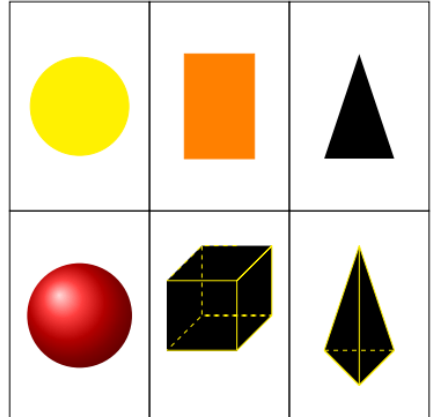
Figure 6. Convex sets.